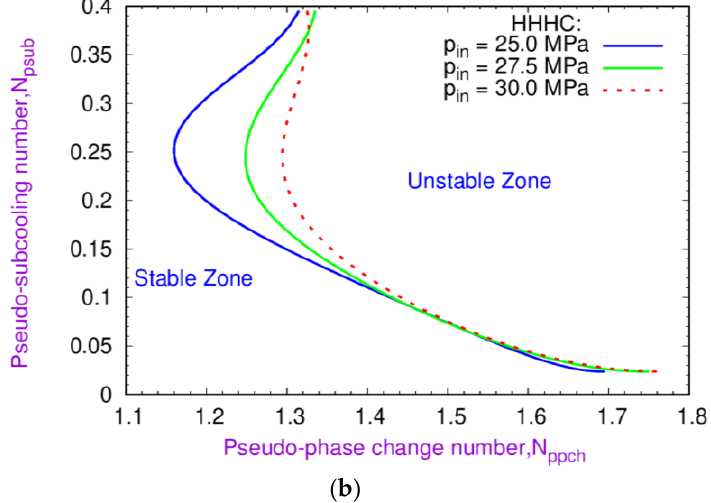
Figure 9. Effect of pressure on the DWI of the loop: ( a ) specific enthalpy vs. power; ( b ) (N ppch ) vs. (N psub ) plane.